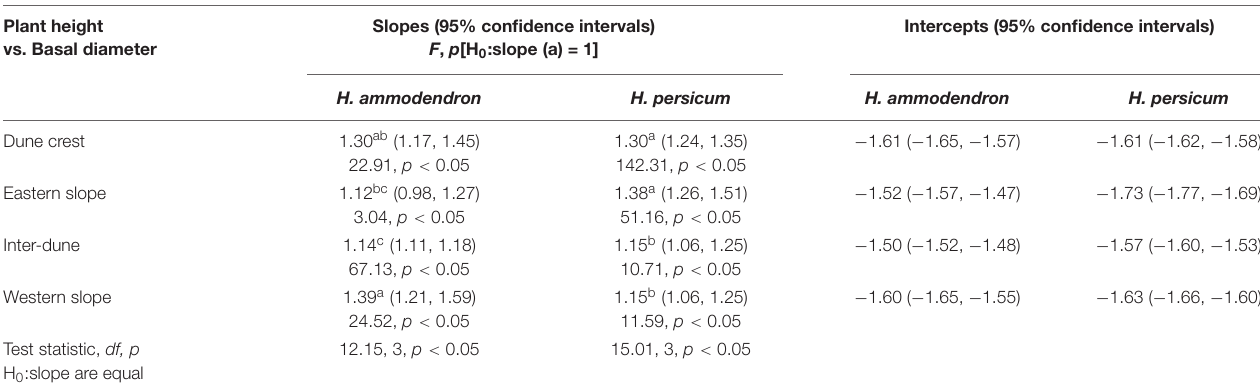
TABLE 3 | Results for SMA fitted slopes between plant height and basal diameter of Haloxylon ammodendron and H. persicum at different terrains. Plant height vs. Basal